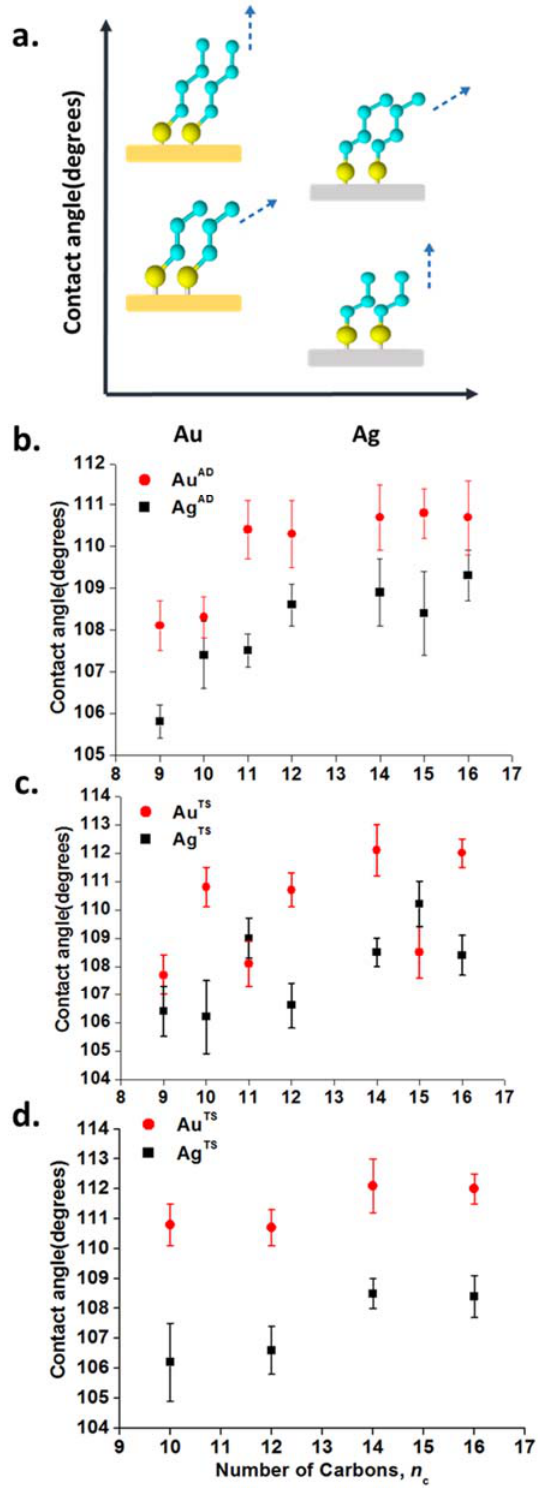
Figure 7. ( a ) Schematic illustration of the structural effect of the SAM on metal surfaces. Orientation of the terminal moiety inverts with the change of the substrate; SAM E on Au orients like SAM O on Ag and vice versa ; ( b ) θ s of water on n-alkanethiolate SAMs formed on Au AD and Ag AD substrates; ( c ) odd-even effects in the hydrophobicity of alkanethiolate SAMs formed on smoother Au TS and Ag TS substrates; and ( d ) θ s of SAM E on Au TS and Ag TS substrates show a significant difference in the values of θ